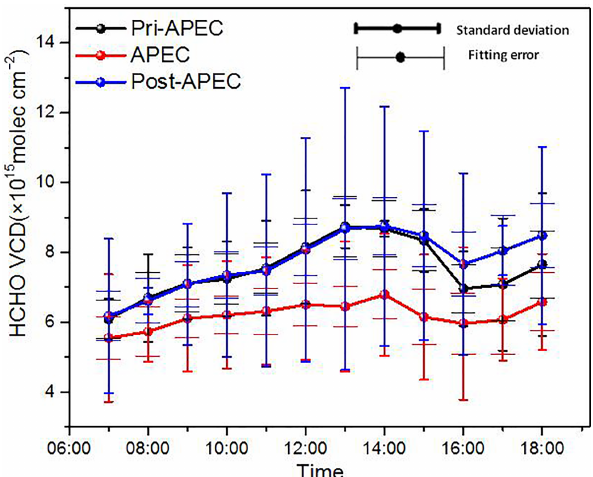
Figure 13. Averaged diurnal variation in HCHO VCDs measured by MAX-DOAS in three episodes around APEC. The short cap width of the error bars denotes the 1 σ standard deviations around the mean analysis values. The long cap width of the error bars de- notes the fitting